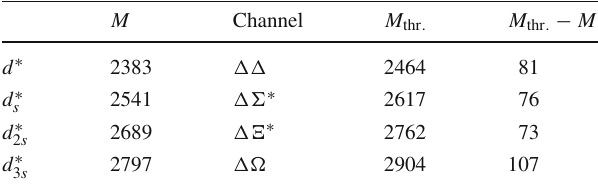
Table 3 Masses of d ∗ ( 2380 ) and its flavor SU(3) partners. The masses M , the corresponding baryon-baryon thresholds M thr . , and their differ- ences M thr . − M are in